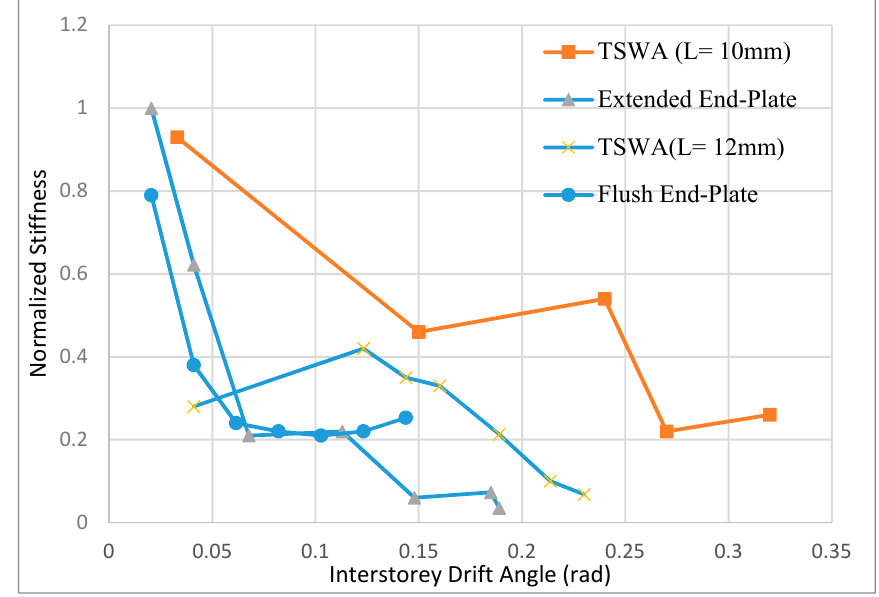
Figure 18. Stiffness degradation versus inter-storey drift angle for semi-rigid connections. Figure 18. Sti ff ness degradation versus inter-storey drift angle for semi-rigid